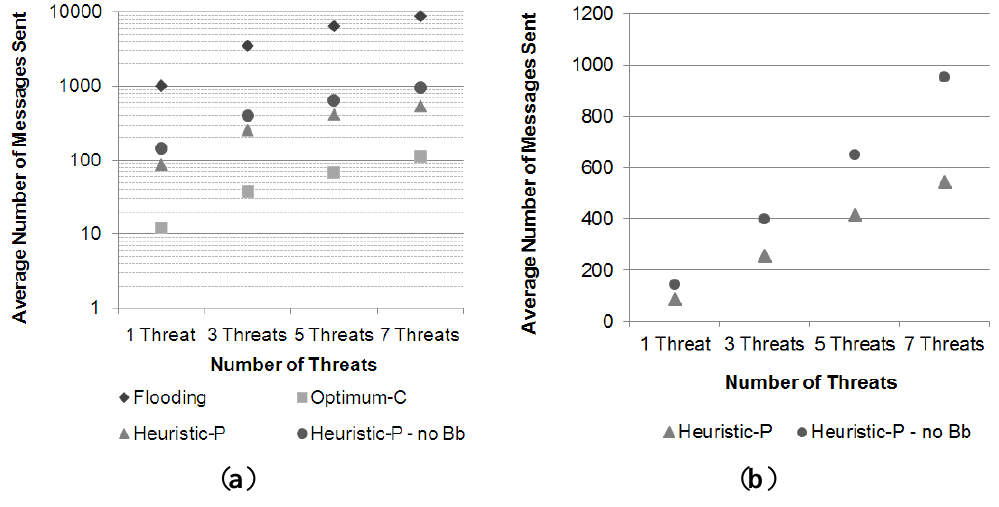
Figure 16. Cost of the pheromone strategy with (Heuristic-P) and without (Heuristic-P—no Bb) backbone: ( a ) cost comparison with the two reference solutions in a semi-log graph; ( b ) Cost comparison between the variations of the pheromone strategy in a linear